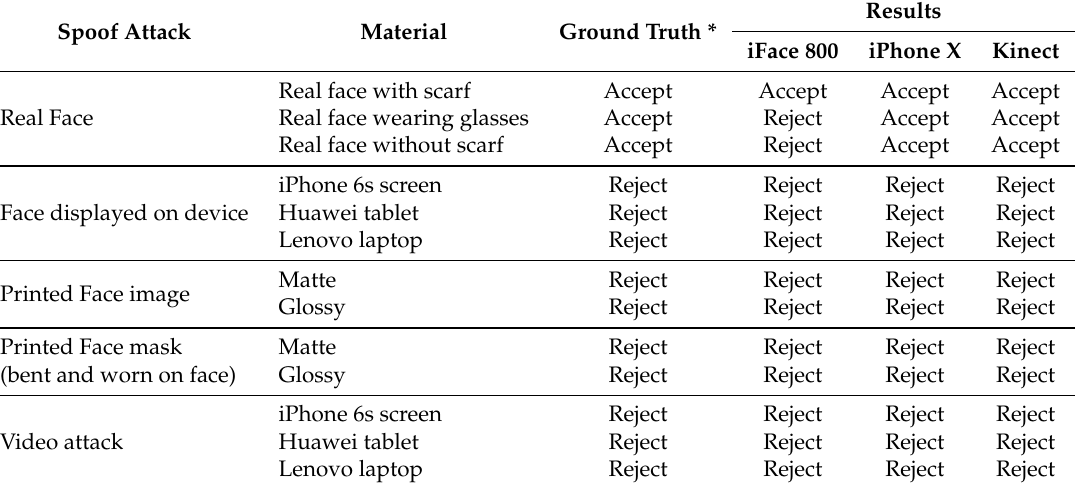
Table 5. Summary of Spoof Attack